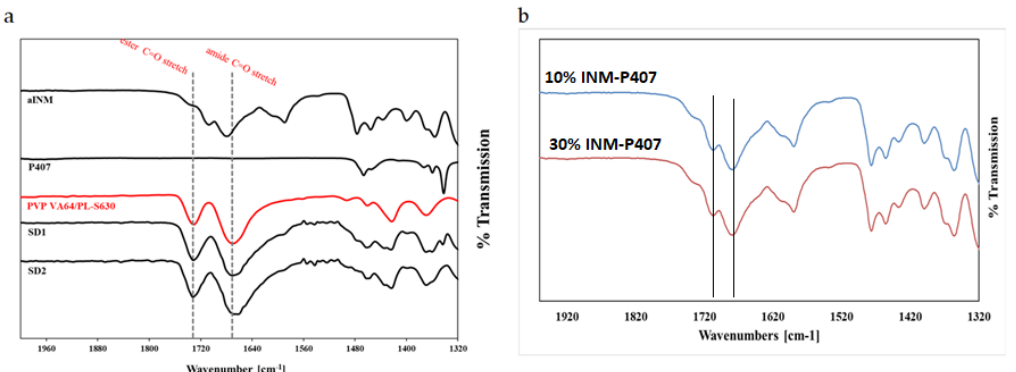
Figure 2. ( a ) ATR-FTIR Spectra of pure components and selected SD formulations (30% INM) showing a shift in the amide carbonyl C=O from 1672 cm − 1 to 1680 cm − 1 . There is no shift in the vinyl acetate carbonyl peak as a result of its weaker hydrogen bond potential. ( b ) ATR-FTIR spectra of binary SDs (controls) of 10% and 30% INM-P407 drug – polymer mixtures.